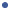
Coupling chemistries for polyP attached to three different bridging linkers.A) Biotinylation of cystamine-coupled polyP. After EDAC-mediated coupling of cystamine to polyP1000, the resulting conjugate was reacted with sulfo-NHS-LC-biotin (●), or was reduced with TCEP and reacted with maleimide-PEG2-biotin (▲). Extent of biotinylation was evaluated using the thrombin-binding assay. B) Fluorescent labeling of cystamine-coupled polyP, resolved on PAGE. The image on the left is the gel following staining with toluidine blue, photographed with white light, while the image on the right is the same gel before toluidine staining, photographed under UV illumination. Lane 1, starting polyP1000 preparation. Lane 2, after coupling cystamine to polyP1000, the resulting conjugate was reduced with TCEP and reacted with maleimide-DyLight488, then purified again. C) Biotinylation of peptide-coupled polyP via sulfhydryl labeling. After EDAC-mediated coupling of the peptide, KACAK, to polyP, the resulting conjugate was reduced with TCEP and reacted with maleimide-PEG2-biotin. Extent of biotinylation was evaluated with the thrombin-binding assay. D) Biotinylation of polyP using copper-free click chemistry. After EDAC-mediated coupling of DBCO-PEG4-amine to polyP1000, the resulting conjugate was reacted with biotin-PEG3-azide and purified. Extent of biotinylation was evaluated with the thrombin-binding assay.